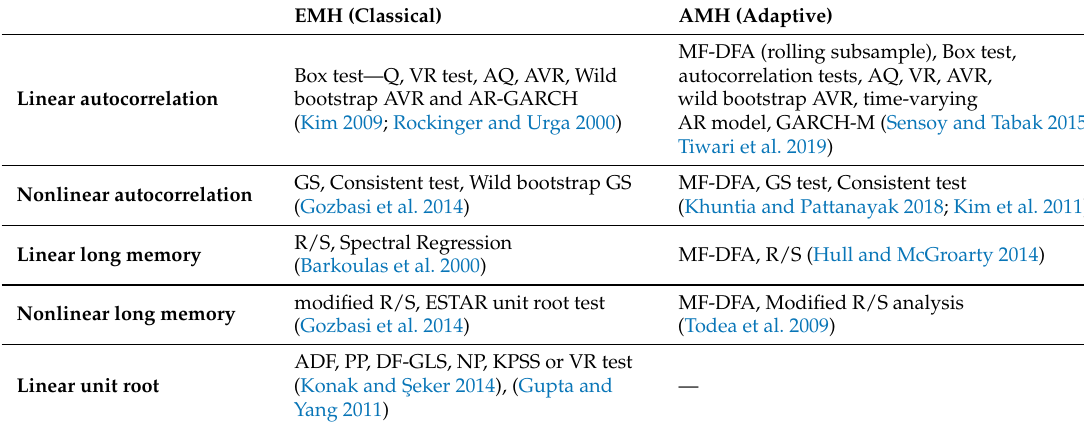
Table 1. Review matrix for return predictability studies.